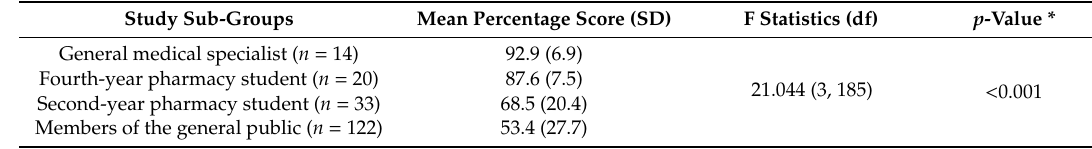
Table 2. Mean percentage of AF knowledge scores of the study sub-groups.